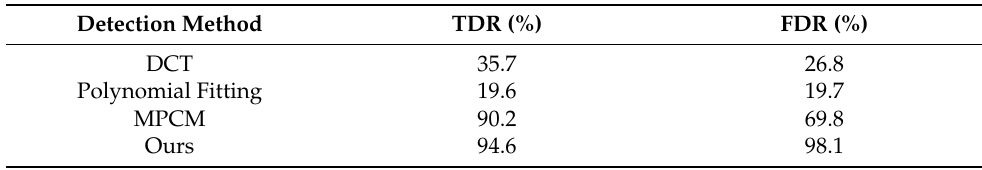
Table 4. Comparative evaluation of different